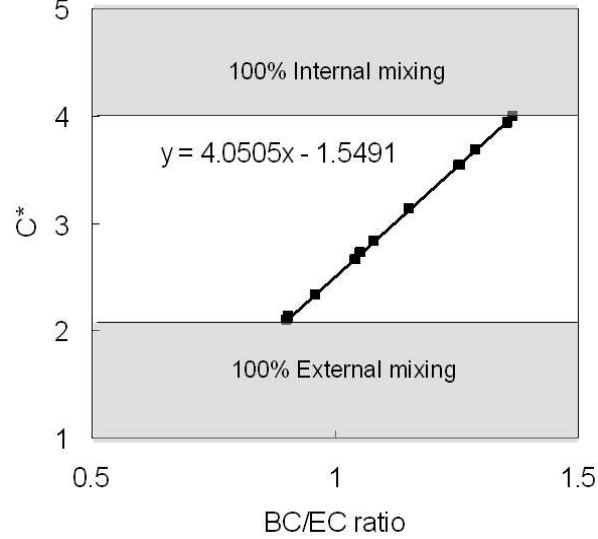
Fig. 3. Retrieval of multiple scattering correction factor ( C ∗ ) for aethalometer measurement based on BC/EC